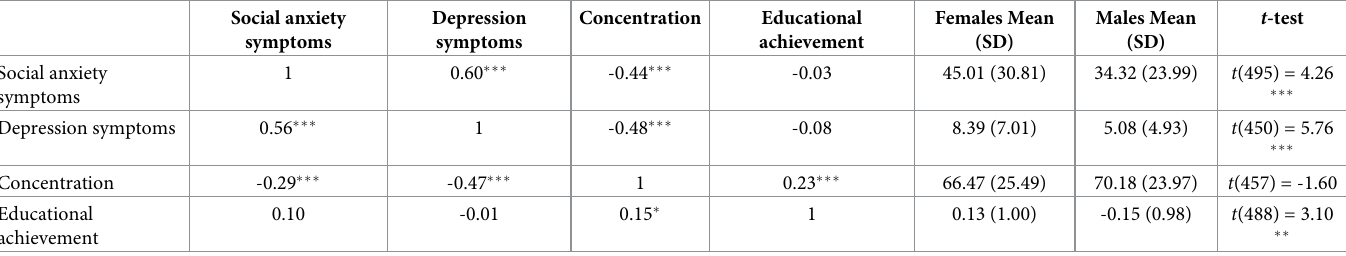
Table 2. Descriptive statistics and Pearson’s correlations of main study variables split by gender (correlation coefficients for females [N = 274] presented above the diagonal, for males [N = 235] below)